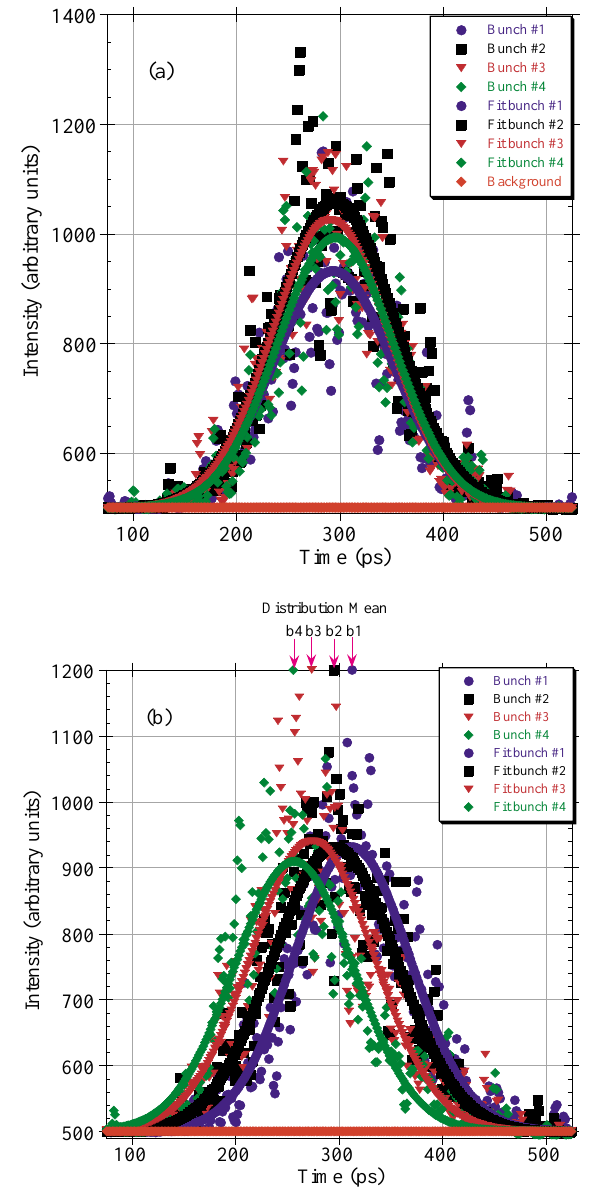
FIG. 13. (Color) The four longitudinal profiles from a single image when the dipole mode coupled bunch instability is (a) not present and (b) present. The mean of the individual distributions when the instability is present is shown above (b). The total positron current when these images were taken was 276